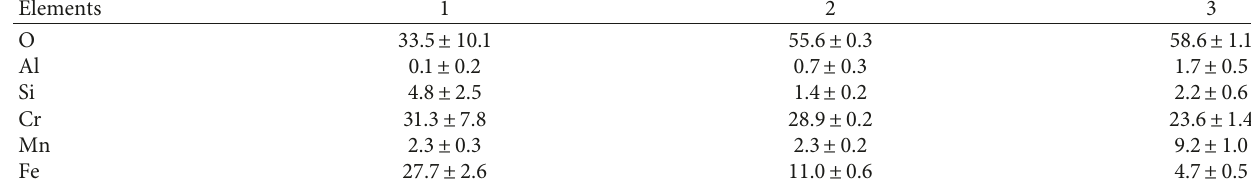
Table 4: The elemental analysis (EDS spot) for the different phases (marked) in Figure 19 (atomic percent).